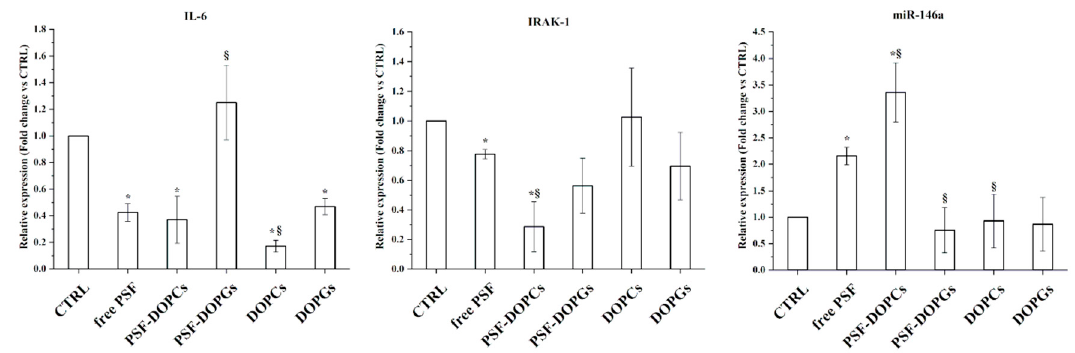
Figure 5. Effect of free P. spinosa fruit extract (free PSF), incorporated extract (PSF-DOPCs and PSF-DOPGs), and empty vesicles (DOPCs and DOPGs) on the IL-6, IRAK-1, and miR-146a expressions. RT–qPCR values are reported as fold induction related to CTRL. The values reported are the mean ± SD of three independent experiments. * p < 0.05 vs. CTRL (Student’s t -test). § p < 0.05 vs. P. spinosa extract.